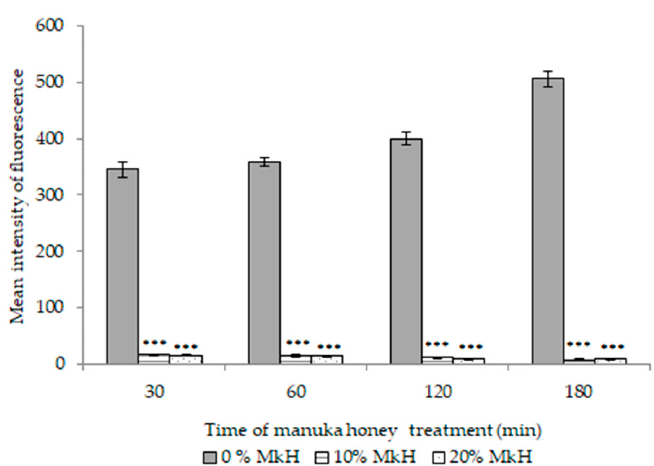
Figure 4. E ff ect of MkH on S. aureus CECT 86 metabolic activity, evaluated using calcein-AM staining. Data at each time point corresponds to mean ± standard deviation. NS indicate no significant di ff erences and asterisks indicate significant di ff erences (*: p < 0.05; **: p < 0.01; ***: p < 0.001) between treated cells vs. the control (non-treated cells). p -values, indicate significant di ff erences ( p < 0.05) between the two honey concentrations tested.